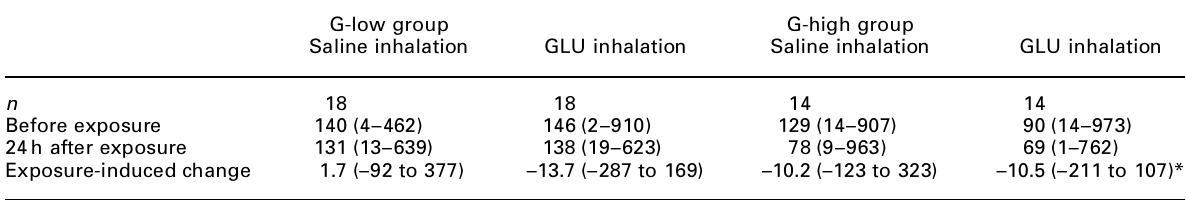
Table 3. IL-10 (pg/ml) secreted from PBMC stimulated with LPS in vitro before and 24h after saline and (1 ® 3)- b - D -glucan (GLU) inhalations G-low group